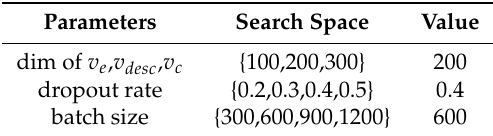
Table 3. Hyper-parameters for the entity embedding model. Here, we choose Adam as our optimizer, with learning rate of